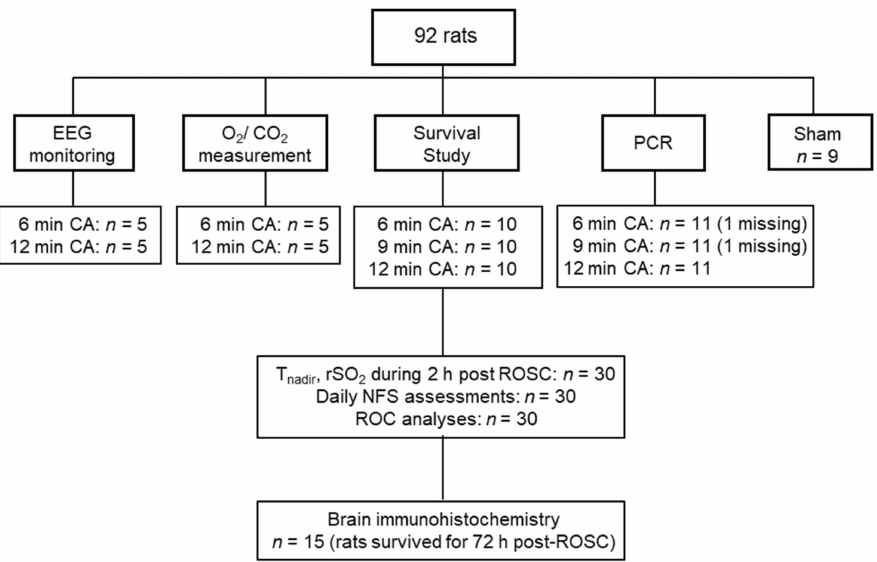
Figure 1. Flow diagram of the experimental groups. Data for two samples (in 6 and 9 min CA groups) in the PCR analysis were missing, due to technical failures. Brain samples from sham- operated rats were used for brain immunohistochemistry ( n = 2) and PCR analysis ( n = 7). EEG; electroencephalography, O 2 ; Oxygen, CO 2 ; carbon dioxide, PCR; polymerase chain reaction, CA; cardiac arrest, rSO 2 ; regional cerebral oxygen saturation, ROSC: return of spontaneous circulation, NFS; neurological function score, ROC analyses; receiver operating characteristic